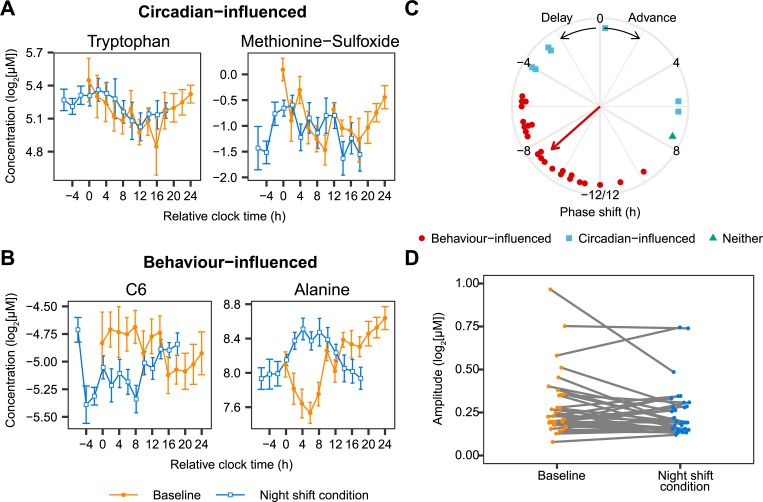
Identification of circadian- and behaviour-influenced metabolites.(A, B) Examples of metabolites that are influenced by the circadian cycle (A: tryptophan and methionine sulfoxide) and that are influenced by the behavioural cycle (B: hexanoylcarnitine [C6] and alanine). Data are presented as mean ± SEM. Relative clock time reflects the time since the start of the individual habitual rest period during baseline. (C) Phase shift during the night shift condition relative to baseline of the 32 metabolites that are significantly rhythmic at both baseline and during the night shift condition. Symbols represent whether the metabolites were classified as circadian-influenced, behaviour-influenced, or neither. The direction of the arrow represents the average phase shift of the behaviour-influenced metabolites. Length of the arrow represents the mean resultant vector length, a measure of the spread of the circular data. No arrow is shown for the circadian-influenced metabolites, because the phase shift of the metabolites was not nonuniformly distributed (p = 0.16, Rayleigh test). (D) Amplitude of the 32 metabolites that were identified as rhythmic during baseline and the night shift condition. Numerical data underlying the results presented in this figure are available in S2 Data. C6, hexanoylcarnitine.